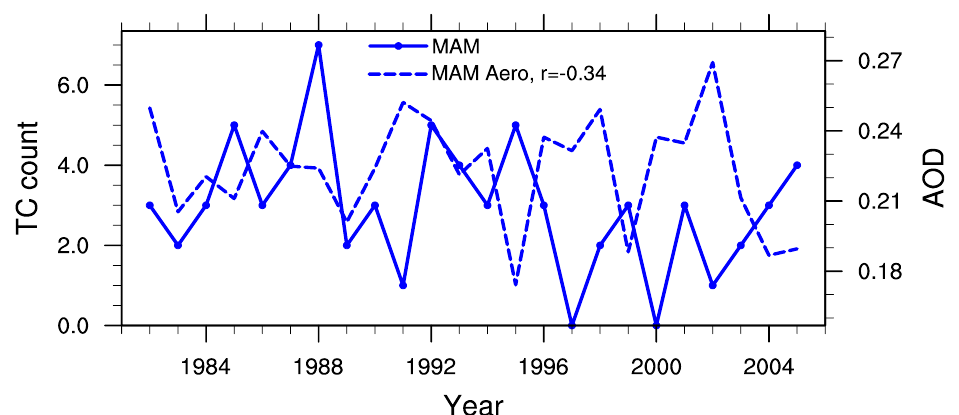
Figure 7. Interannual variability for (top) IBTrACS count, MERRA-2, and AVHRR; (middle) BAM TC count and aerosols; (bottom) MAM TC count and aerosols. Solid lines are the TC count, and dashed lines are AOD. Calculations are seasonal (June – November) averages from 1982 to 2005. Correlation between AOD and tracks is shown in the legend. The range of values in BAM AOD is much smaller than the other two.